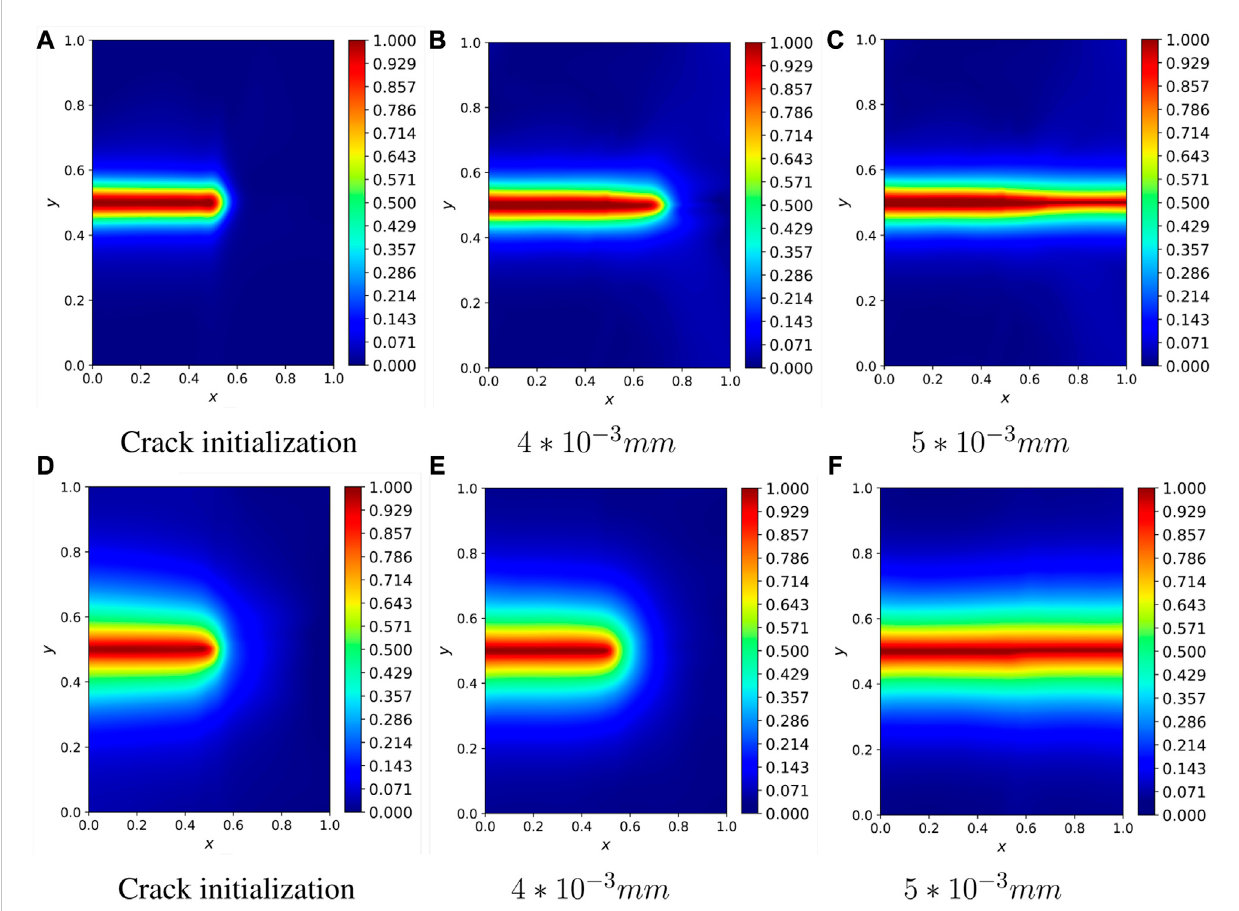
FIGURE 7 Phase fi eld images of single-edge notched plates with the same model size and different l 0 values. The upper half: l 0 = 4 l p =0.05. The low half: l 0 = 10 l p = 0.125. (A) Crack initialization, (B) 4 p 10 − 3 mm, (C) 5 p 10 − 3 mm, (D) Crack initialization, (E) 4 p 10 − 3 mm, (F) 5 p 10 − 3